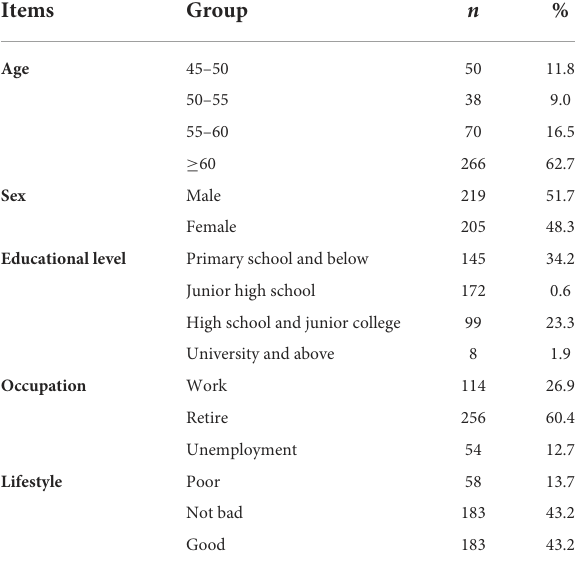
TABLE 1 General demography data ( n =